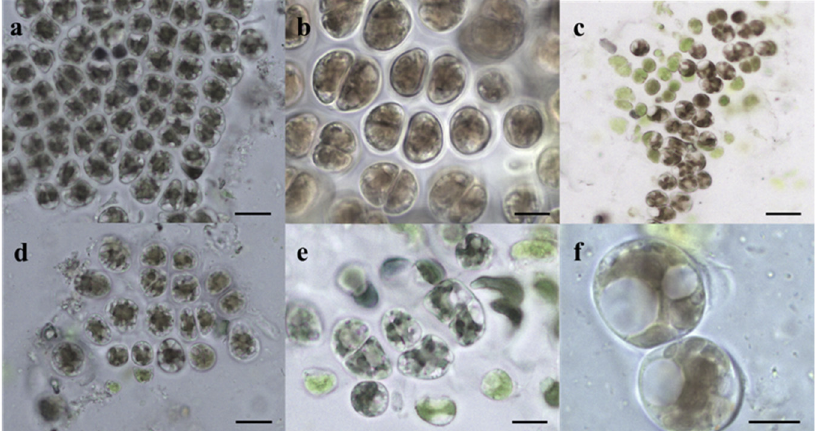
Figure 3. Enzymatic hydrolysis process of N. yezoensis and the isolated protoplasts ( a – e ): the enzy- matic hydrolysis process enlarged the gaps between algal cells (scale bar = 20 µm); ( f ): single proto- plast (scale bar = 10 µm).